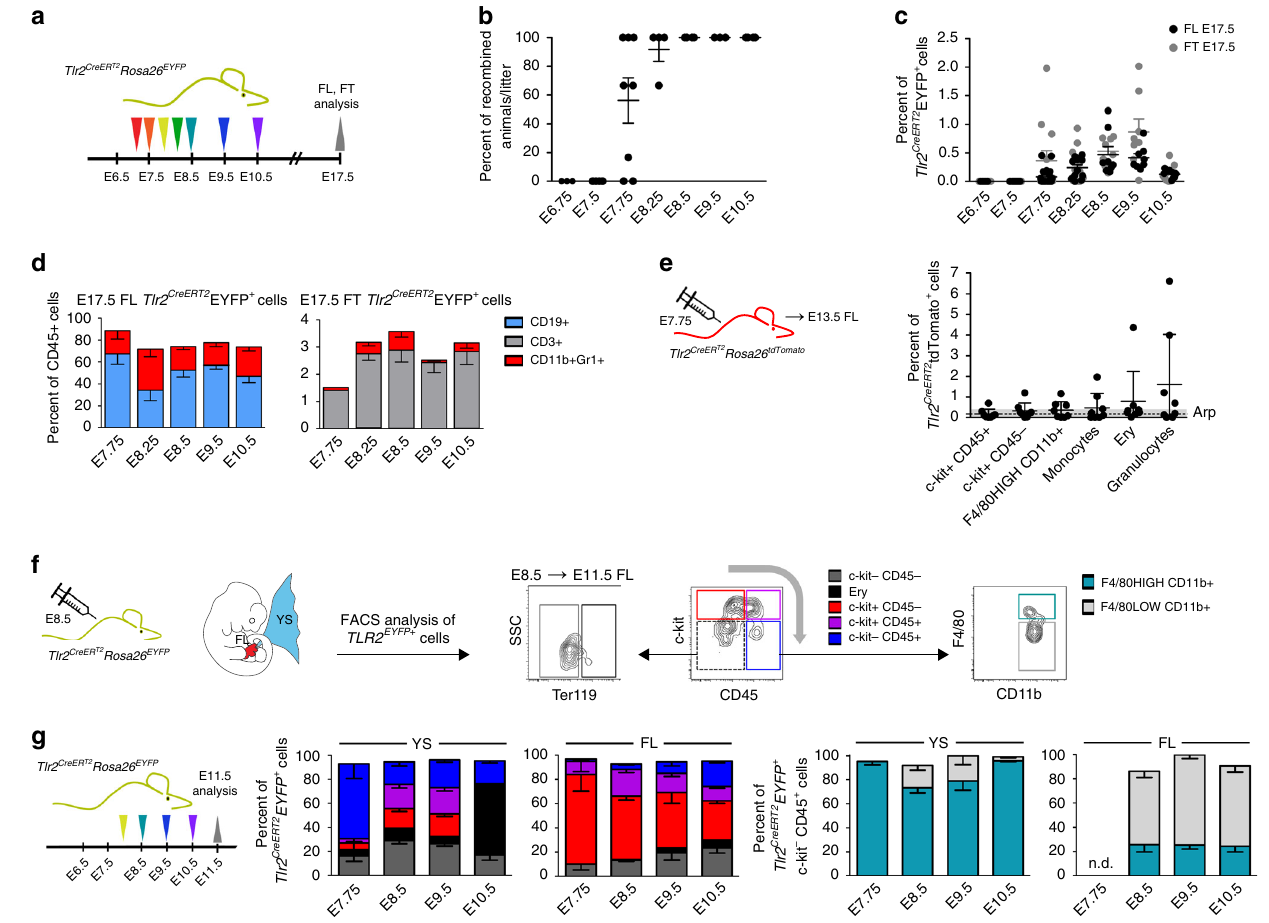
Fig. 4 At E7.75, Tlr2 -labeled progenitors contribute to embryonic and fetal hematopoiesis. a Experimental design of the fate mapping of cells with an active Tlr2 locus. b The percentage of EYFP + embryos among all Tlr2 CreERT2 Rosa26 EYFP embryos in the same litter pulsed with one dose of 4-OHT from E6.75 to E10.5 was analyzed at E17.5 by FCM (mean ± SEM; n = 3 – 8 litters). c Percentage of Tlr2 CreERT2 EYFP + cells in E17.5 fetal liver (FL, black dots) and E17.5 fetal thymus (FT, gray dots) in embryos described in ( b ); (mean± SEM; n = 6 – 21 embryos). d The hematopoietic fate of Tlr2 CreERT2 EYFP + cells pulsed with one dose of 4-OHT from E7.75 to E10.5 was determined in E17.5 FL and FT by FCM; (mean ± SEM; n = 4 – 8). e Labeling of hematopoietic populations (including granulocytes and monocytes) was determined in E13.5 FL of Tlr2 CreERT2 Rosa26 tdTomato embryos pulsed with a single dose of 4-OHT at E7.75 (mean ± SEM; n = 8; arp = average recombination probability assessed in Ter119 – c-kit – CD45 – cells. f Gating strategy to identify the contribution of Tlr2 CreERT2 EYFP + cells to indicated hematopoietic populations in E11.5 YS and FL. g Fate tracing of E11.5 Tlr2 CreERT2 EYFP + cells pulsed with one dose of 4-OHT from E7.75 to E10.5 (mean ± SEM; n = 5 – 15) was analyzed by FCM according to ( f ). Source data are provided as a Source Data fi